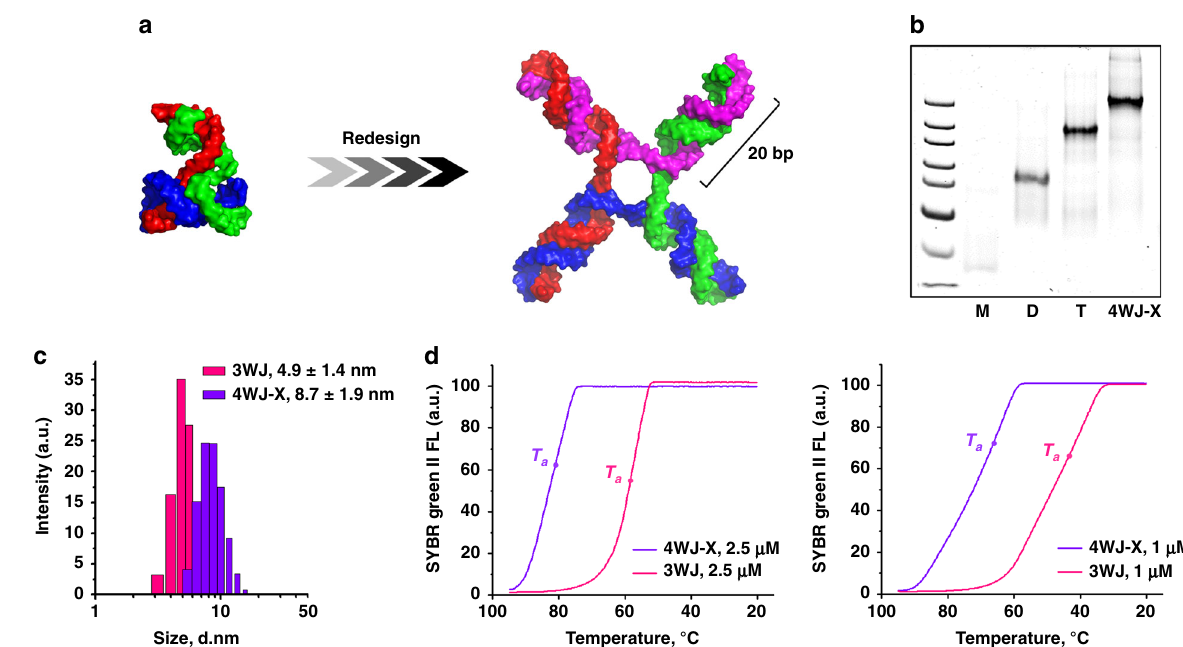
Fig. 1 Design and construction of thermostable RNA 4WJ-X nanostructure. a Hypothetical 3D model of RNA 4WJ-X nanostructure (left), redesigned from pRNA-3WJ motif (right) 25,29 . b Step-wise self-assembly of 4WJ-X, evaluated by native polyacrylamide gel electrophoresis (PAGE) (size marker: ultra-low range DNA ladder; M, D, and T indicate RNA monomer, dimer, and trimer, respectively). c Size comparison of 4WJ-X (purple) and pRNA-3WJ (pink) by dynamic light scattering (DLS) (mean ± SD of one size distribution). d T a comparison of 4WJ-X (purple) and pRNA-3WJ (pink) in representative annealing curves, measured by real-time-PCR (RT-PCR) ( n = 3 independent samples over three independent measurements). Source data are provided as a Source Data fi